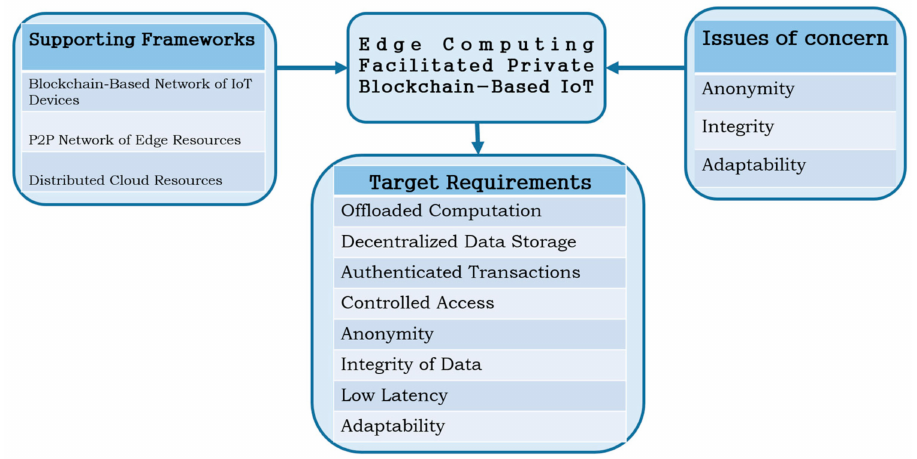
Figure 3. Building blocks and target requirements for the edge computing leveraged private blockchain-based internet of things (IoT)